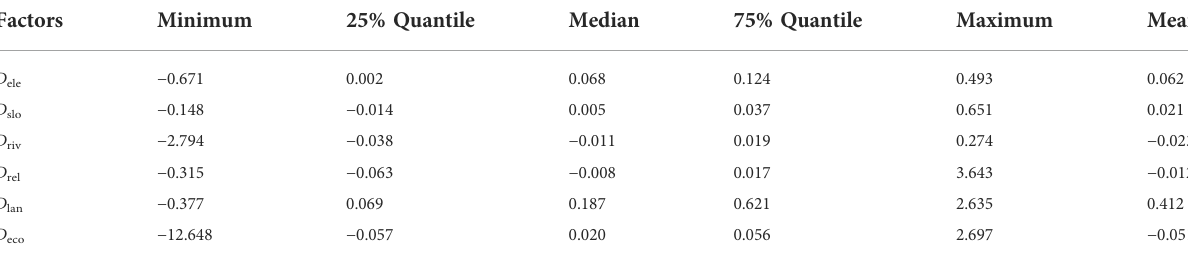
TABLE 5 Statistics of regression parameters of the GWR